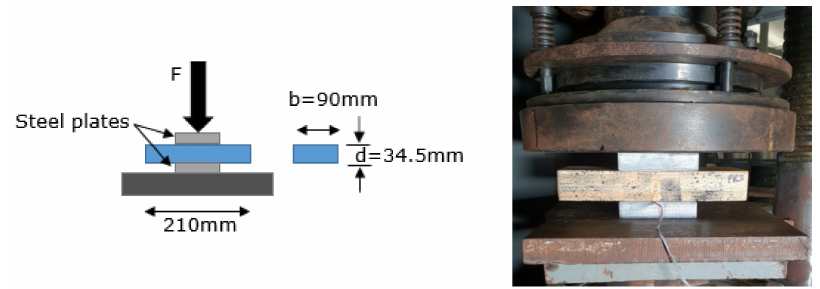
Figure 5. CPerpG test configuration.